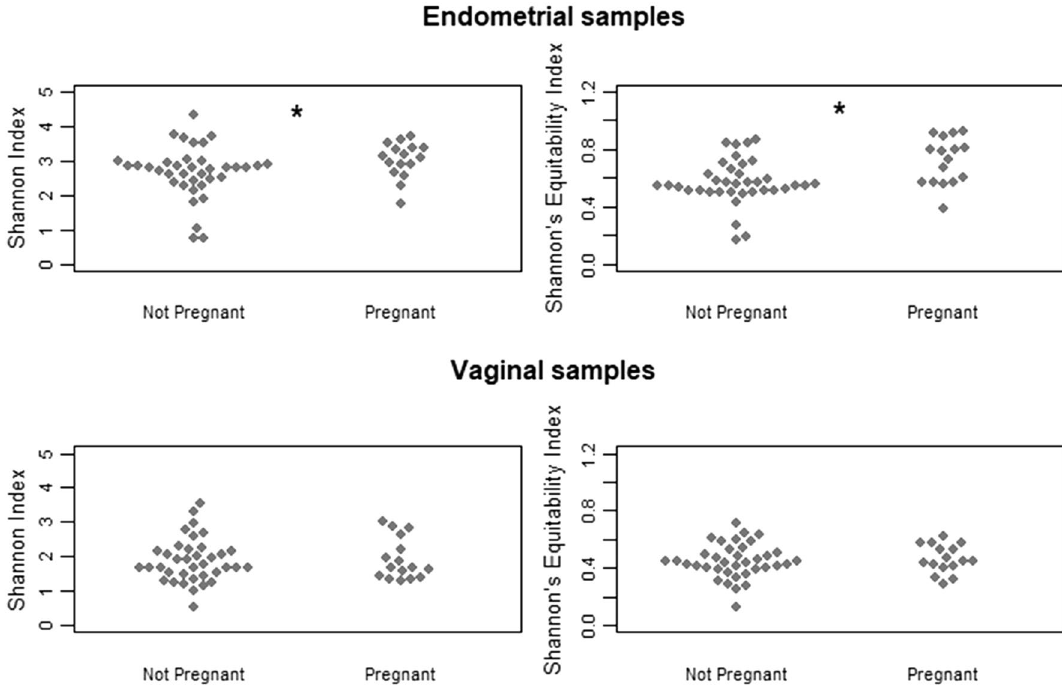
Figure 2. Shannon and Shannon’s equitability indexes in women who did and did not become pregnant. A statistically significant difference emerged for both indexes in the endometrial microbiomes (p = 0.036 and p = 0.002, respectively). Conversely, no significant differences could be observed for the vaginal